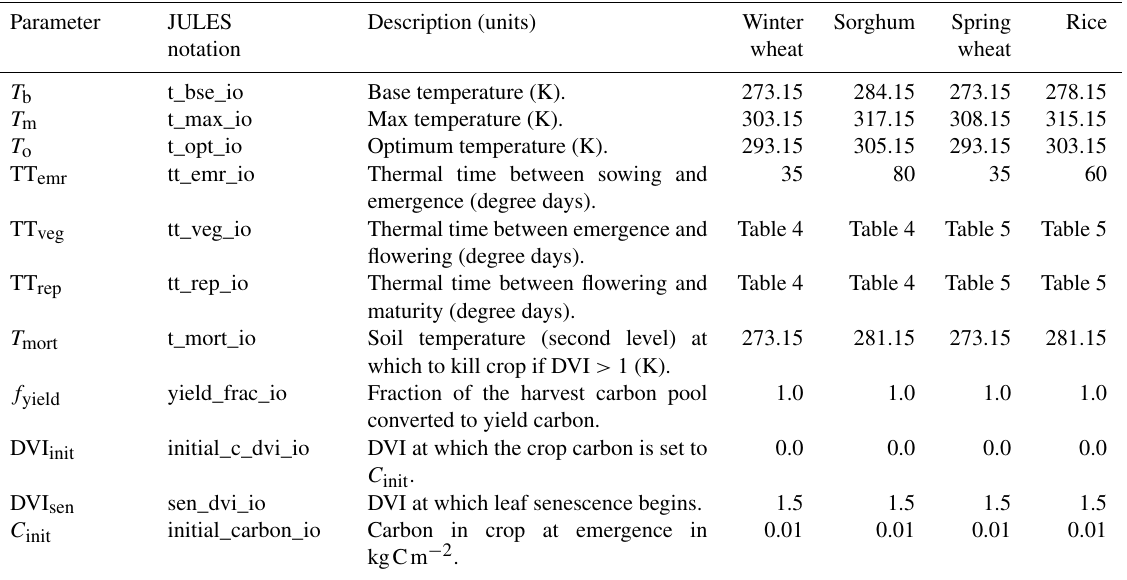
Table 3. JULES crop parameters used in this study. The sorghum cardinal temperatures are from Nicklin (2012) with the other parameters being those used for maize in Osborne et al. (2015). We include only the values that have been changed or added since Osborne et al. (2015). Table 3 of Osborne et al. (2015) provides the original PFT parameters and Table 4 of Osborne et al. (2015) provides the original crop